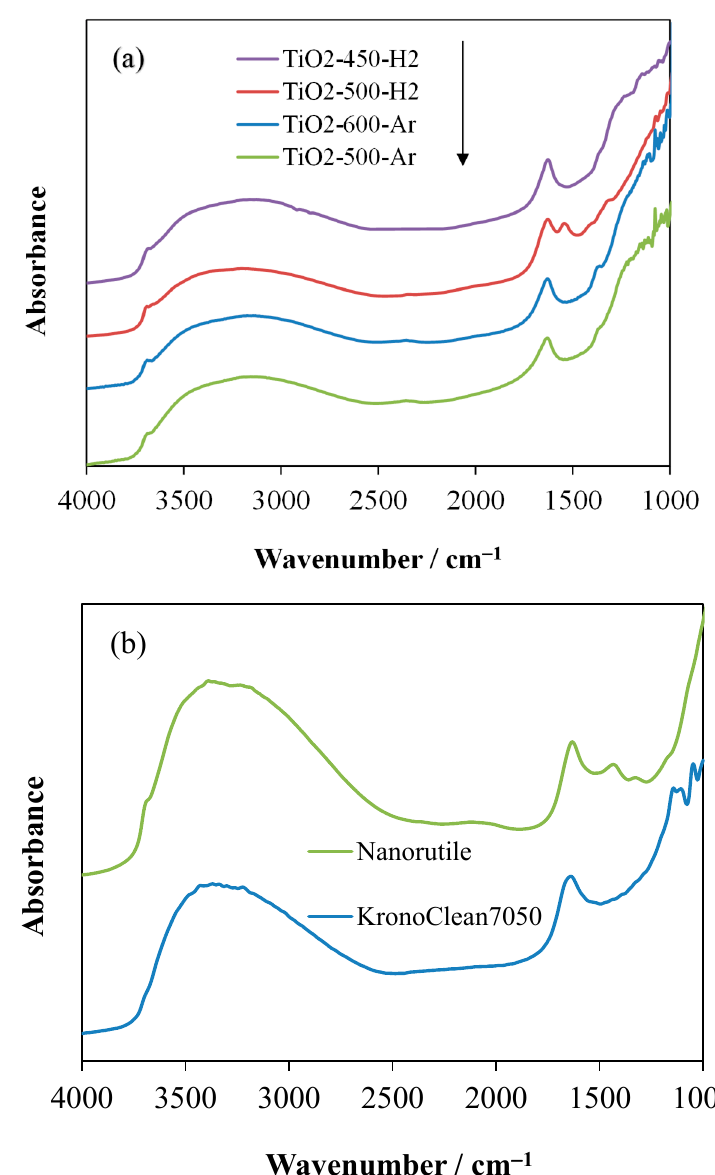
Figure 6. FTIR spectra of the titania samples, ( a ) as prepared and ( b ) commercial.